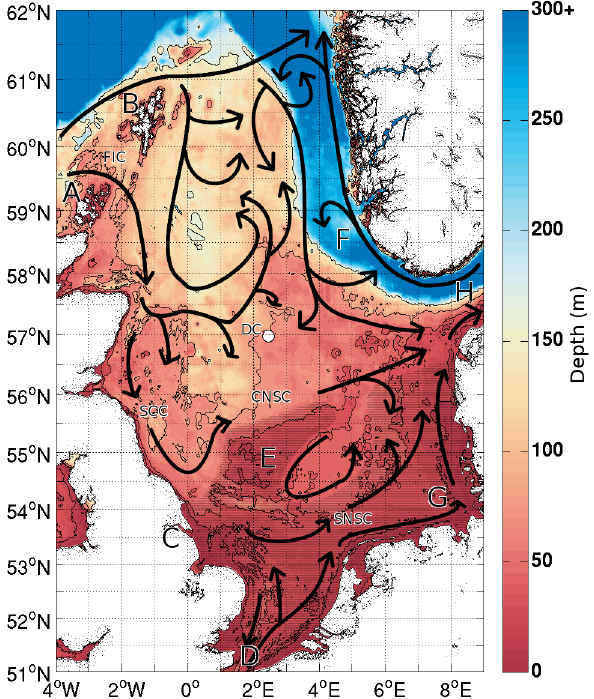
Figure 1. Bathymetry of the study area in metres (GEBCO, 2010). Depth contours have been added for the 20, 40, 80, and 160m iso- baths. The region where the glider was deployed is indicated by the large white dot at approximately 57 ◦ N, 2 ◦ 30 (cid:48) E. Major landmarks are indicated as follows: A and B – Shetland and Orkney isles; C – Humber estuary; D – the Channel; E – Dogger Bank; F – Norwe- gian Trench; G – German Bight; H – Skagerrak. The general circu- lation of the North Sea (adapted from Turrell et al., 1992 and Hill et al., 2008) is overlaid as arrows for FIC (Fair Isle Current), DC (Dooley Current), SCC (Scottish Coastal Current), CNSC (Central North Sea Current), and SNSC (Southern North Sea Current). Hatch marks cover areas not subject to thermal stratification in